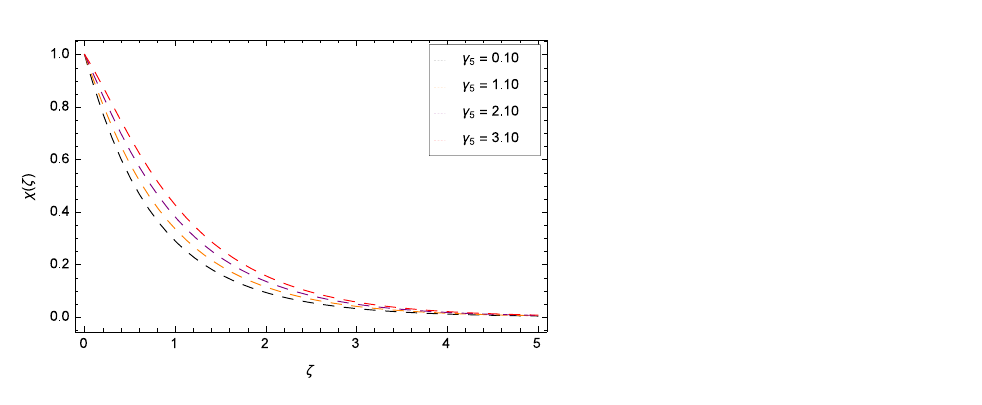
Figure 22. Pattern of graph curves on account of γ 5